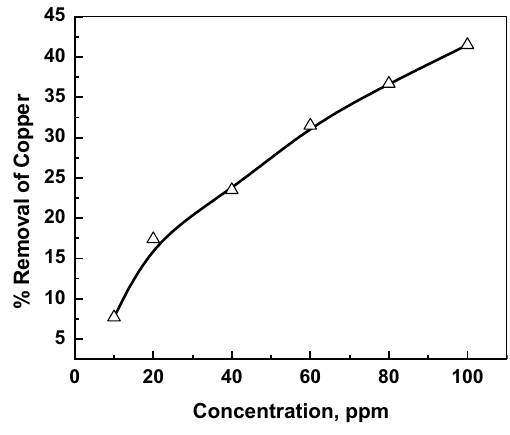
Fig. 9 Effect of variation in the initial